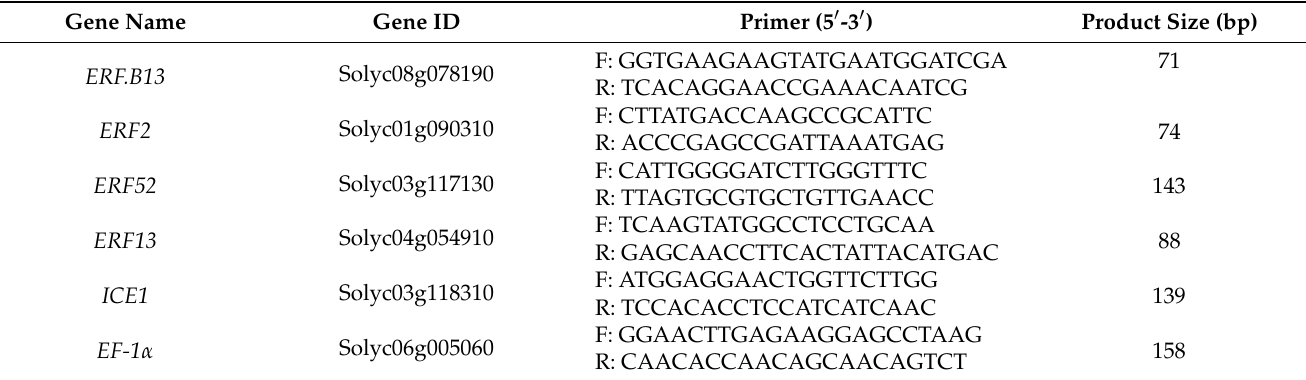
Table 1. List of used primers in real-time PCR